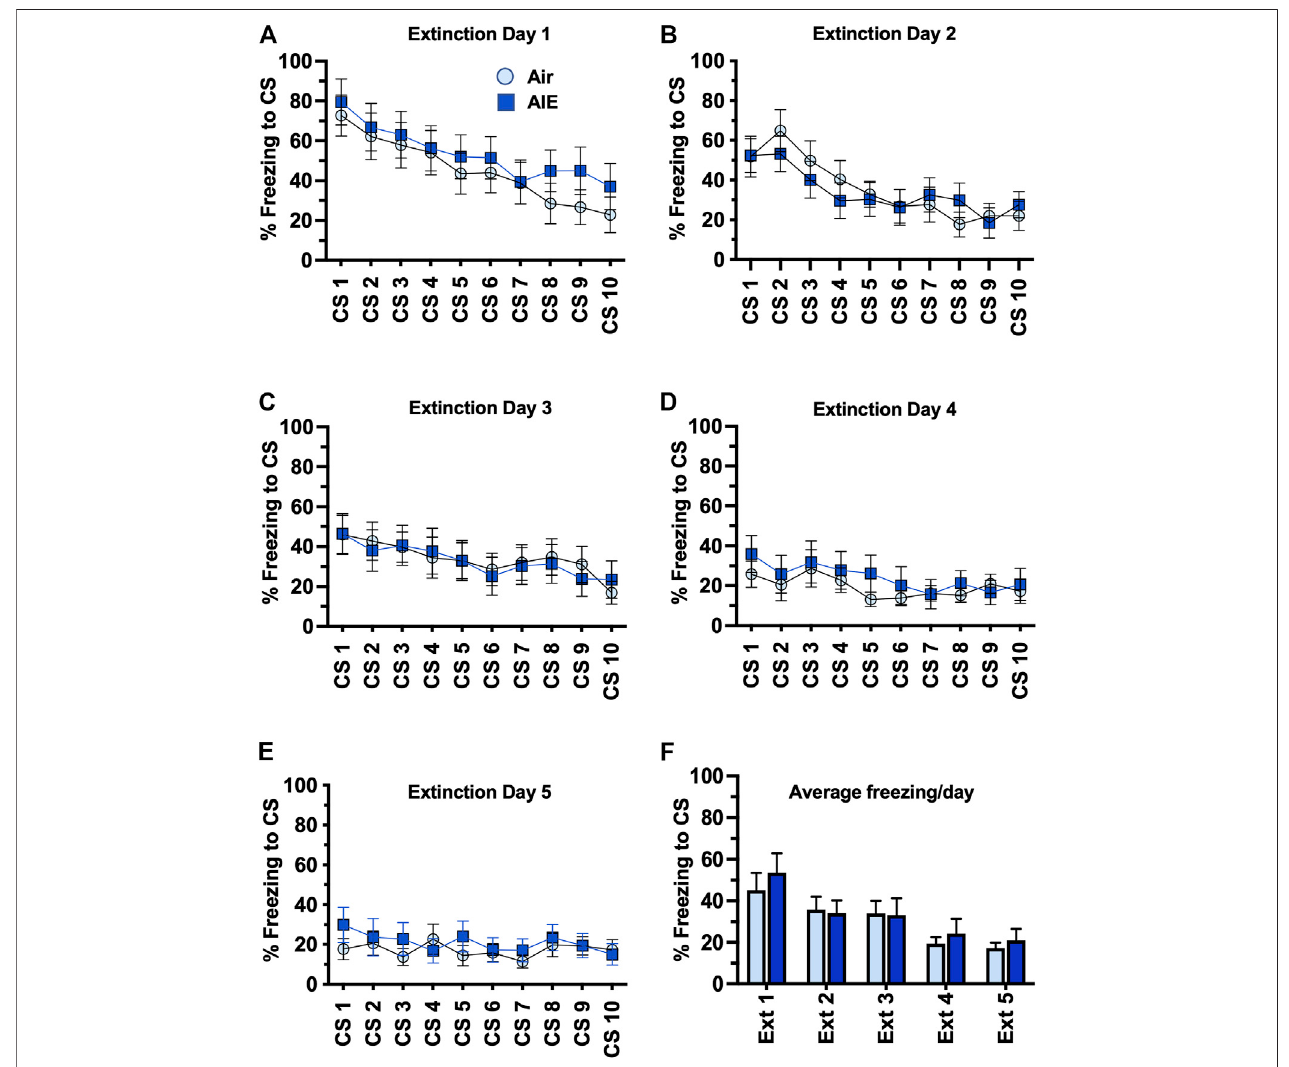
FIGURE4| AIEexposuredidnotalterextinctionofconditionedfearinadultfemalerats. (A – E) Fiveconsecutivedaysofpresentationoftheconditionedtonewithout the shock (10/session/day) resulted in a day and session-dependent reduction of freezing to the conditioned stimulus, but there wasno effect of AIE. (F) Comparison of the average freezing across the 10 tones of each daily extinction session further con fi rmed there was no signi fi cant difference between the Air control and AIE exposed rats. n = 16/group.